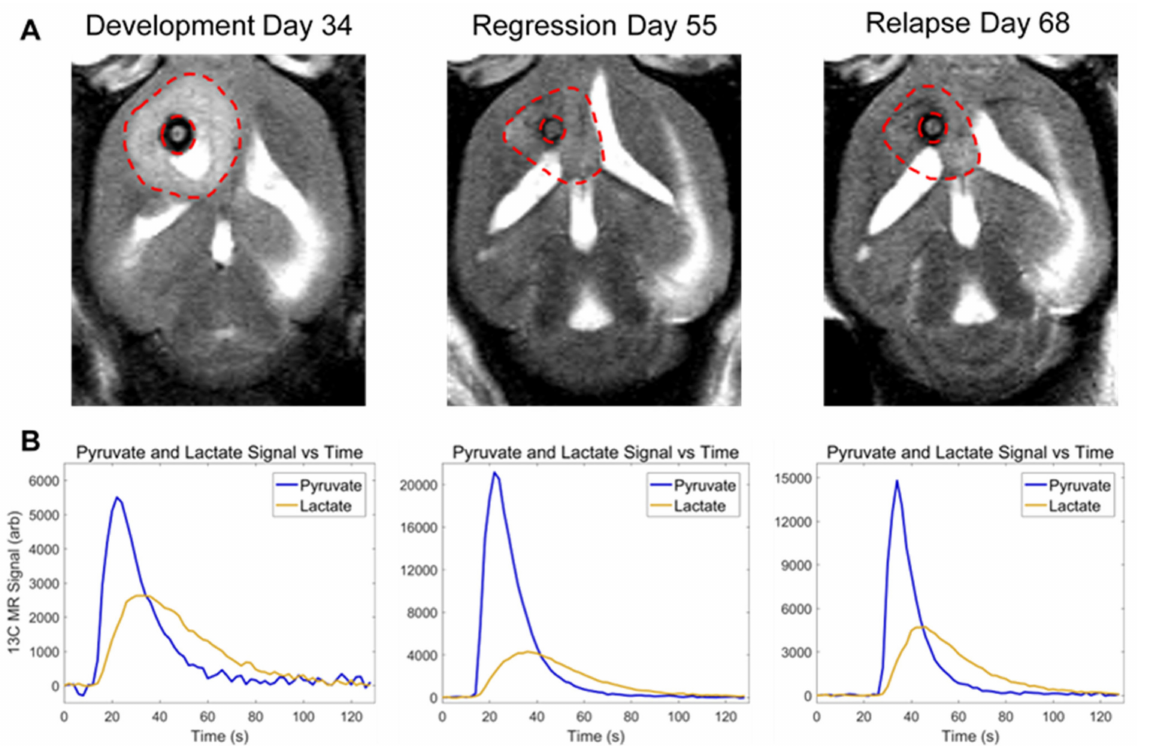
Figure 1. Anatomic and metabolic imaging of tumor-bearing mice over time. Tumor volume ( A ), imaged with T2-weighted MRI, and pyruvate-to-lactate conversion ( B ), measured with hyperpolarized MRS, is displayed at the end of tumor development (Day 34), end of tumor regression (Day 55), and at the point of relapse (Day 68) in the same